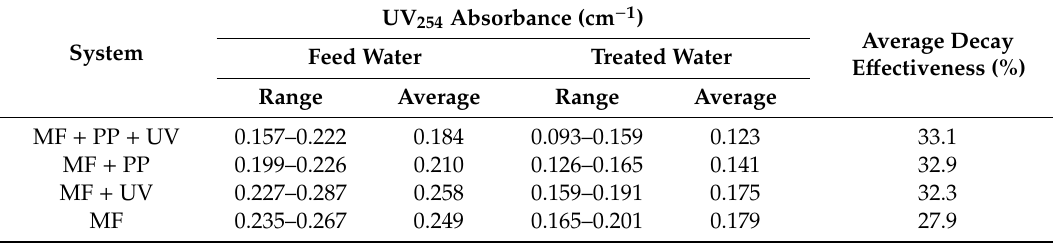
Table 4. Decay e ff ectiveness of DOM (UV 254 absorbance) for the function of microfiltration, adsorption, and photo-oxidation at HA 6 mg / L in the integrated system, of multichannel ceramic MF and pure PP particles, using air backwashing.